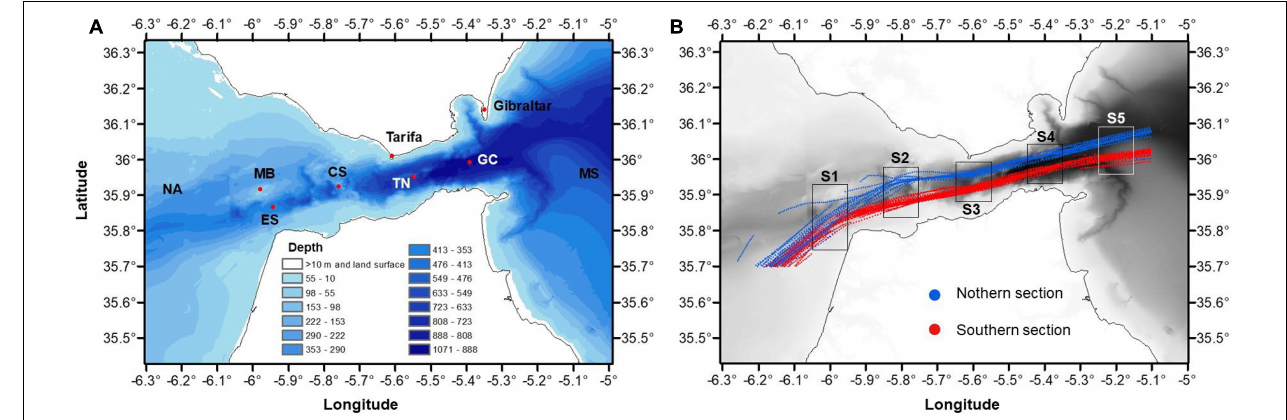
FIGURE 1 | (A) Bathymetric map of the Strait of Gibraltar and location of the topographic features of interest with west-to-east distribution: Majuan Bank (MB), Espartel Sill (ES), Camarinal Sill (CS), Tarifa Narrow (TN), and Gibraltar Central (GC). (B) CanOA-VOS northern (blue) and southern (red) tracks and location of the stations of interest from S1 to